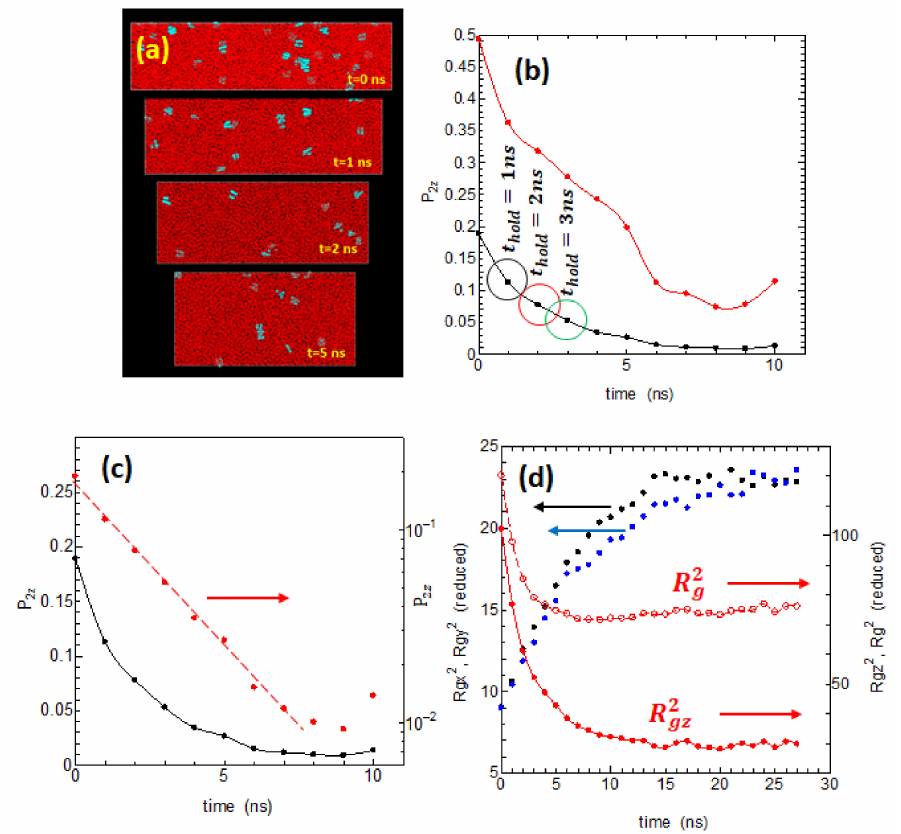
Figure 2. ( a ) The process of annealing the melt at 440 K (well above the melting point) vs. time of holding t hold at 440 K. ( b ) The loss of melt memory in terms of the order parameter P 2 z as a function of time t hold at 440 K. We considered the P 2 z order parameters calculated both from the chord vectors connecting C-C-C atoms (black circles) and from the end-to-end vectors of the chains (red circles). ( c ) The order parameters P 2 z from the chord vectors (black) and those of log ( P 2 z ) (red) are plotted vs. time showing the clear exponential decay of P 2 z with time. ( d ) The changes in the radius of gyration R 2 g as well as its x, y, z components, R 2 gx , R 2 gy , R 2 gz , are plotted vs. time in red open circles, black filled circles, blue filled circles, and red filled circles,